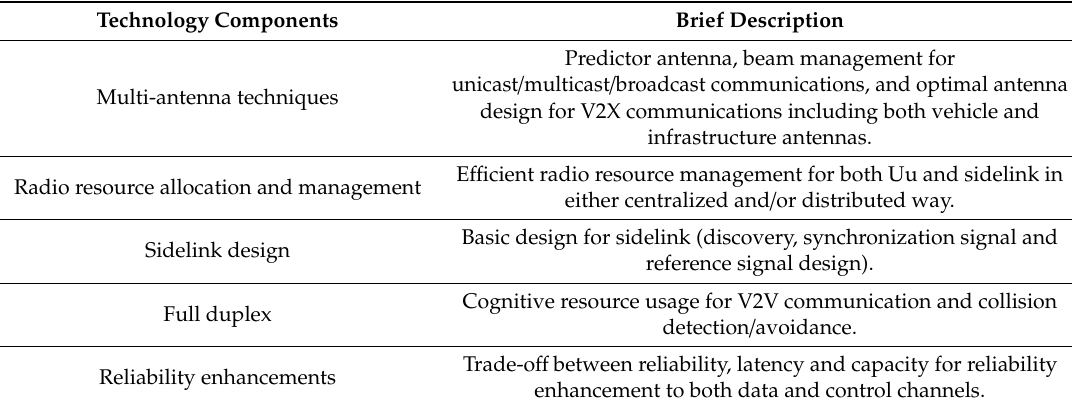
Table 4. Summary of Technology